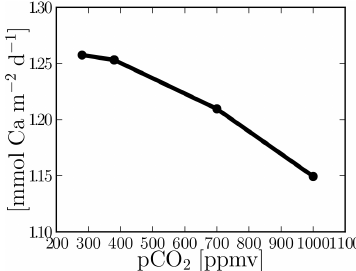
Fig. 8. Effect of changing seawater p CO 2 on the average coral cal- cification